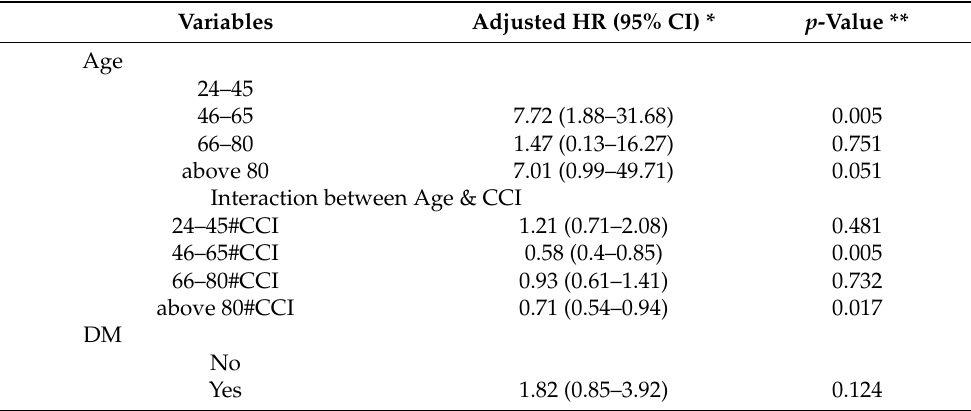
Table 2. Predictors of occurrence of AKI—adjusted model.